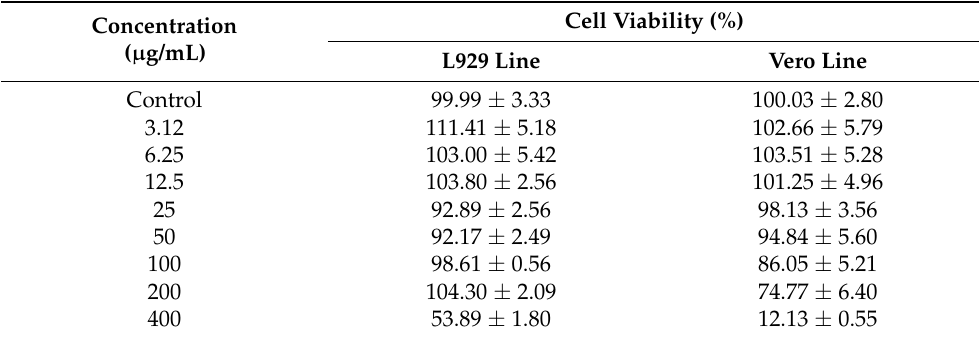
Table 2. Viability (percentage) of L929 and Vero cell lines after contact with the biosurfactant from Bacillus cereus UCP 1615 at different concentrations (data expressed as mean ± SD of the triplicate